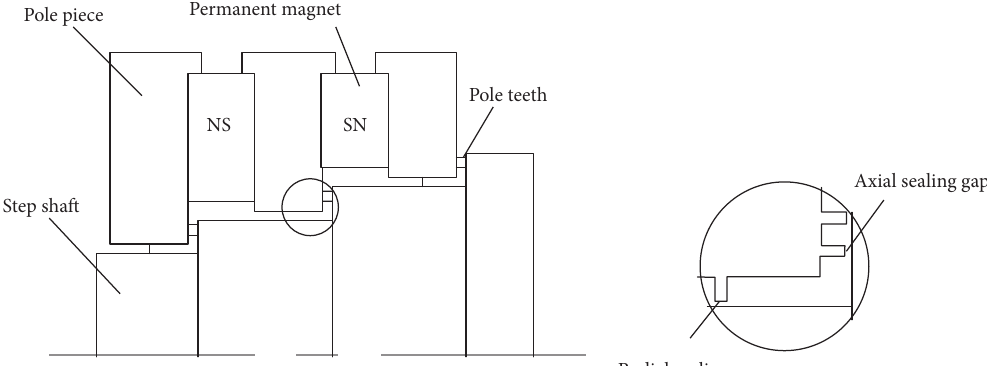
Figure 1: Structural diagram of divergent magnetic fluid seal with dual magnetic source.